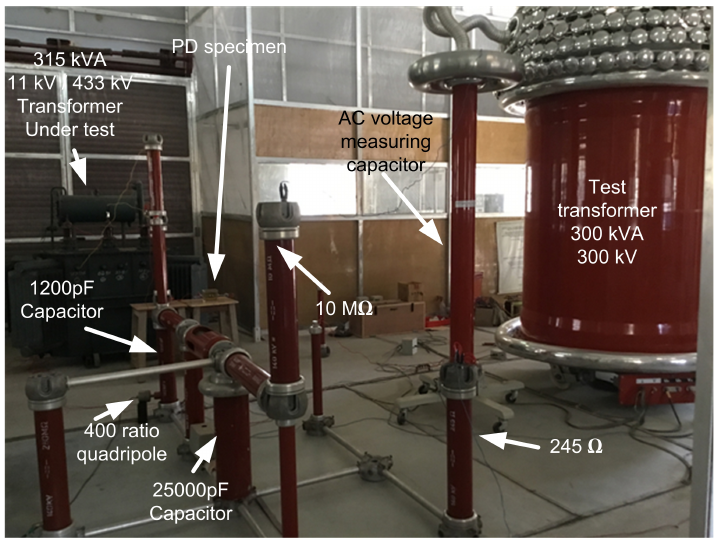
Figure 4. Photograph of the experimental